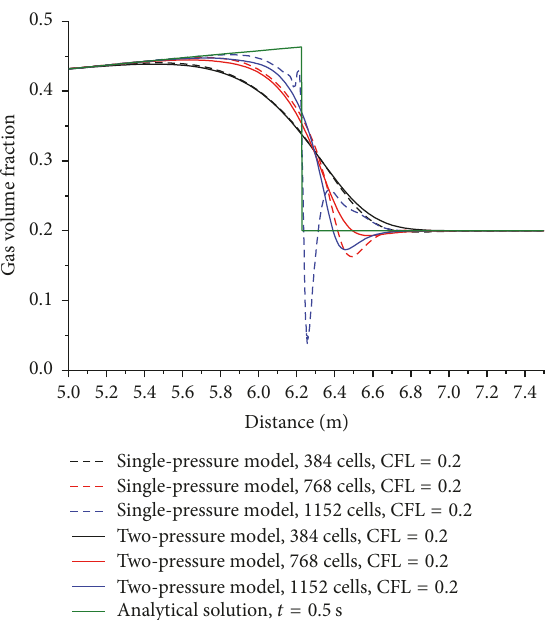
Figure 8: Gas volume fraction comparison between single-pressure model and two-pressure model with FOU scheme and finer cells at time of 0.5 seconds.